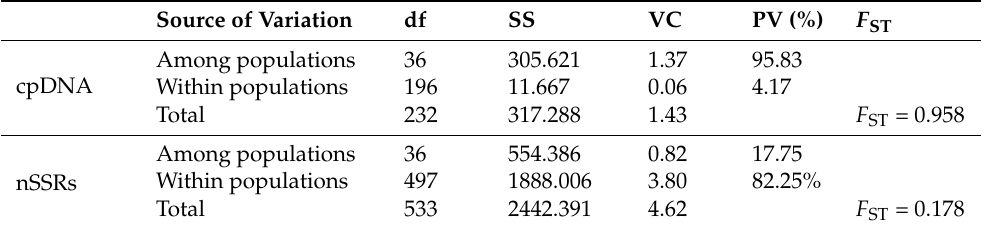
Table 2. Analysis of molecular variance (AMOVA) of the genetic diversity in F. altissima .